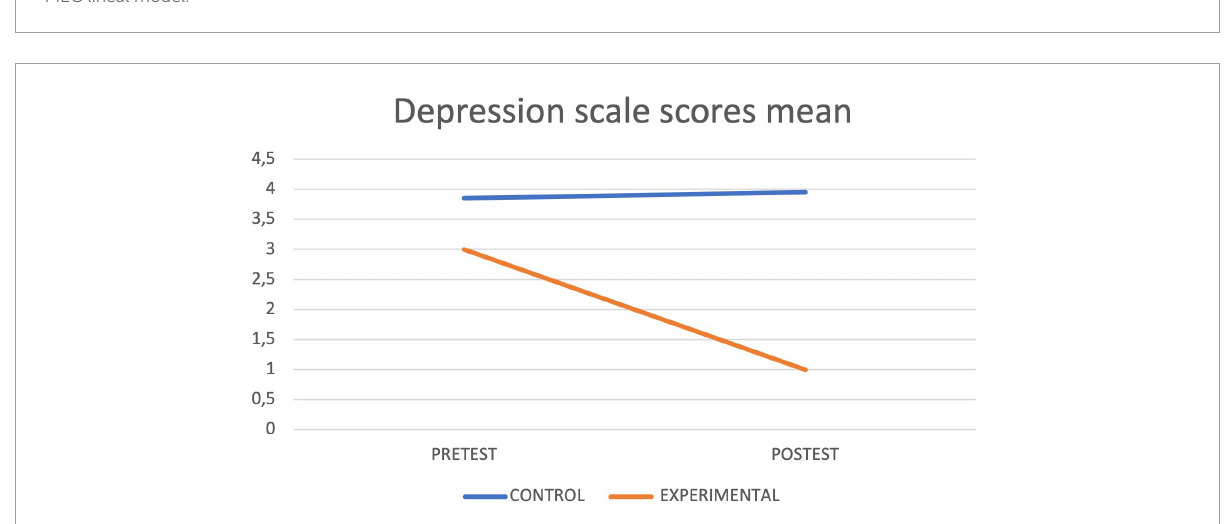
FIGURE3 MEC lineal model.